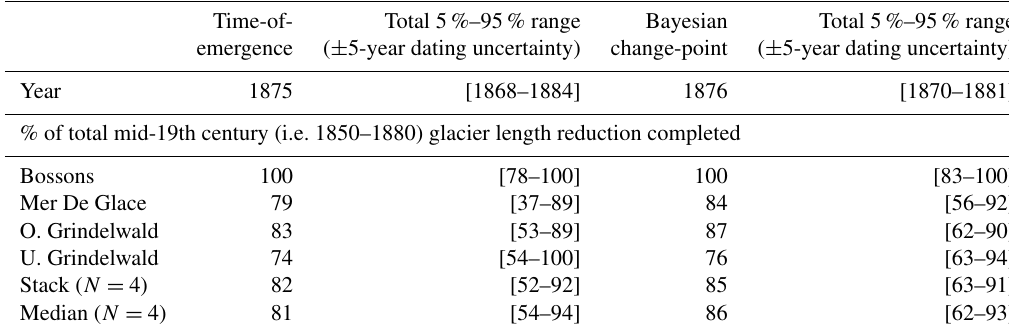
Table 4. Alpine glacier lengths during the emergence of industrial BC deposition (see Fig.